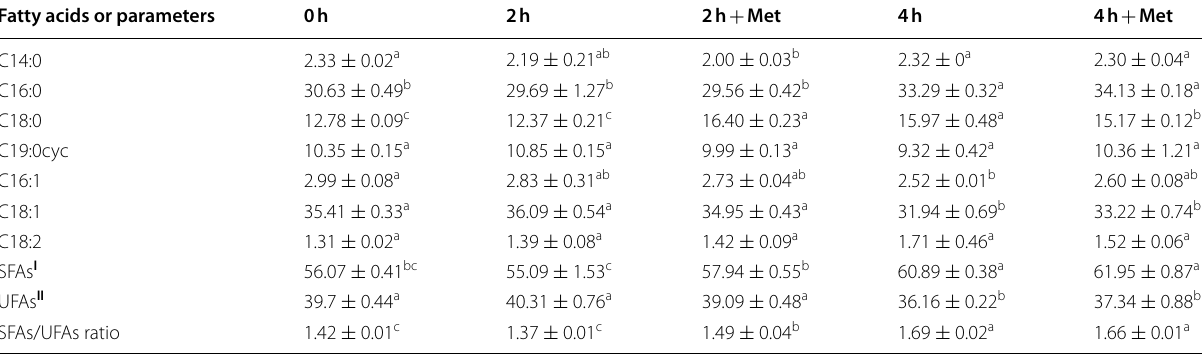
Table 1 Effect of the methionine supply on the fatty acid composition of the membrane phospholipids of L. plantarum XJ25 under acid